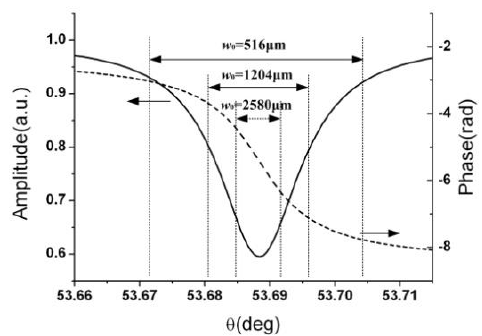
Figure 3. Reflectivity and phase under different incident angles.